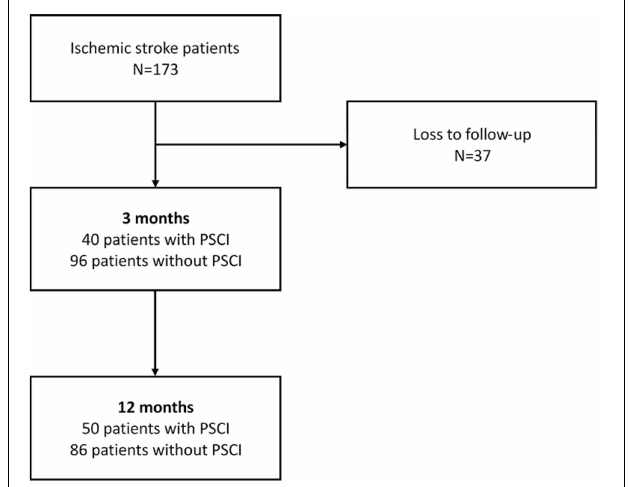
FIGURE 1 | Flowchart of patient enrollment and cognitive function changes during the 12 months’